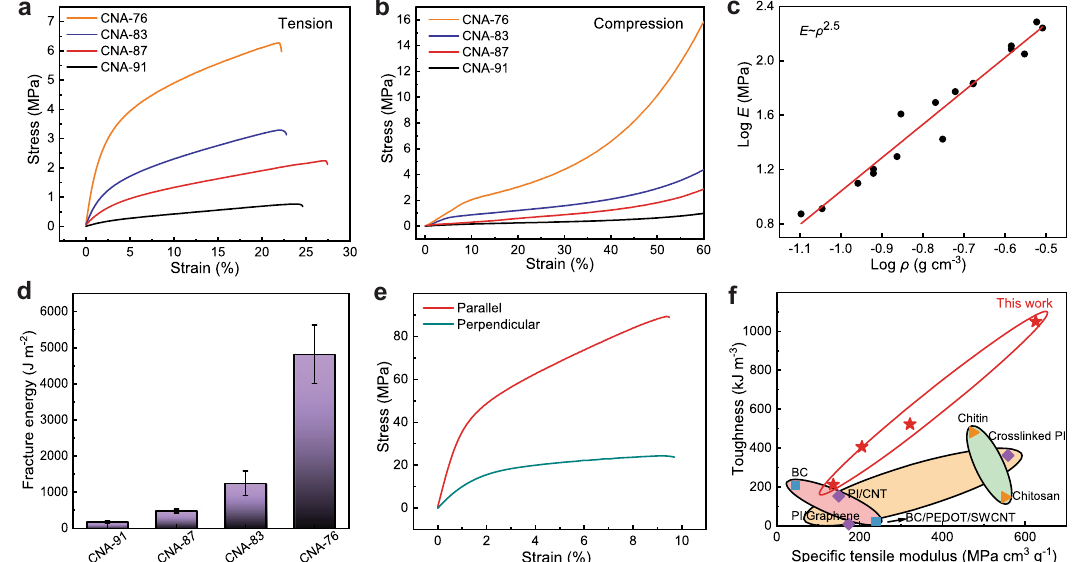
Fig. 2 Mechanical properties. a Tensile responses of CNAs with their porosity ranging from 76% to 91%. b Compressive stress-strain curves of CNAs with various porosity levels. c Tensile moduli of CNAs as a function of their density, obtained from experimental characterization and theoretical fi tting. d Fracture energies of CNAs as a function of their porosity. e Anisotropic tensile responses of an CNA sample with highly oriented fi brils, measured from the directions parallel and perpendicular to the fi bril orientation, respectively. f Toughness and speci fi c tensile modulus of CNAs, as compared with other polymeric aerogels with high mechanical properties. The toughness was calculated by integrating the tensile stress-strain curves from various materials (Supplementary Table 1). Tensile moduli of CNAs as a function of their solid contents porosity may experience fi bril buckling at a lower compressive load, leading to an earlier onset of softening. Finally, the strain follow a relation E (cid:1) ρ 2 : 5 , where E and ρ are the Young ’ s modulus hardening of CNAs under large compressive deformation is likely and density, respectively (Fig. 2c). This relation is typical for foam due to the densi fi cation of fi brils. materials with a random internal structures 28 . Their fracture NATURE COMMUNICATIONS| (2022) 13:4242